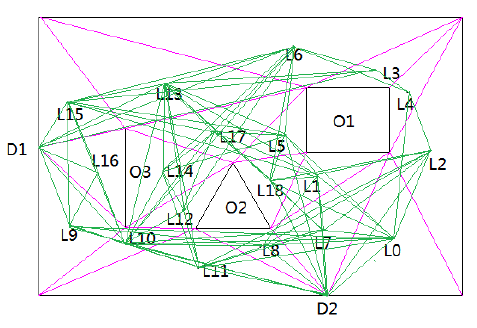
Figure 6. Resulting network for navigation (green lines)